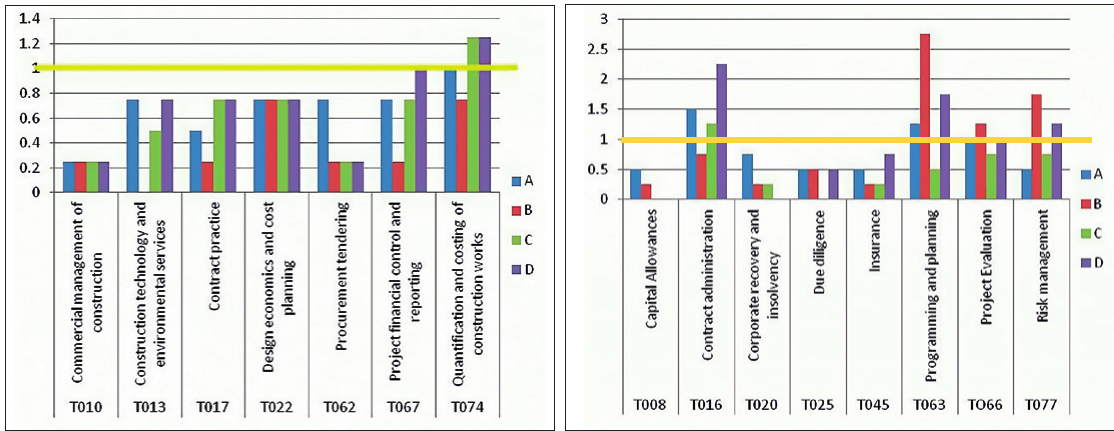
Figure 6. Optional competency mapping scores: Level 1 clearly indicates that all uni- versities do not achieve optional competencies to a benchmark level score of 1.